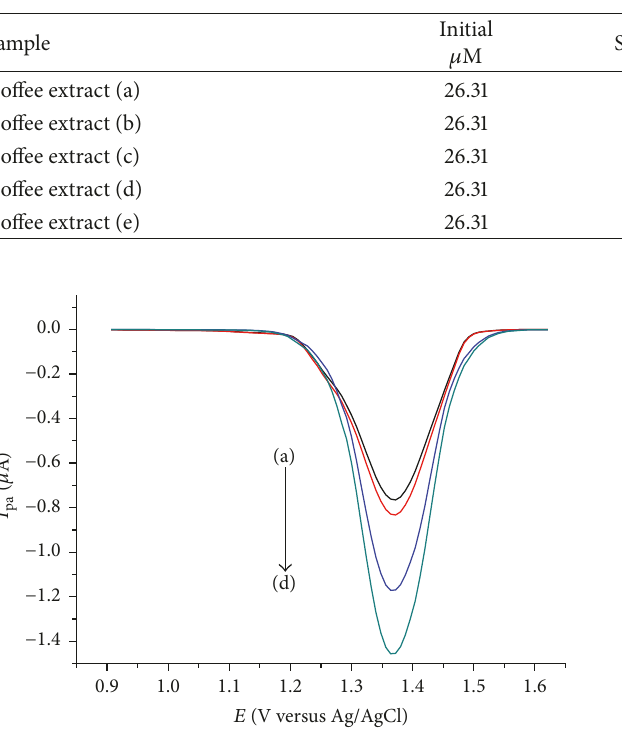
Figure 8: DPVs of LGCE in pH 4 ABS containing aqueous ex-